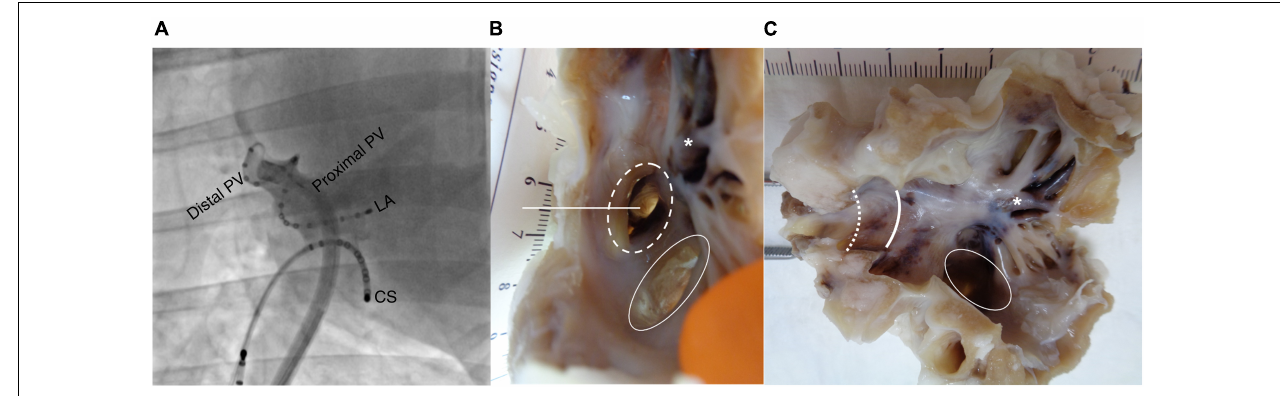
FIGURE 1 | Electrode position and histological preparation. (A) Fluoroscopic image (right anterior oblique view 42 ◦ ) showing the 20-electrode diagnostic spiral catheter positioned in the right pulmonary vein (RPV). A linear catheter is placed in the coronary sinus (CS) as an anatomical reference during the procedure. (B) Image of left atrium (LA) with pulmonary vein (PV) before dissection. Dotted circle: RPV. Intact circle: common left pulmonary vein (LPV). Straight line: incision line through the RPV generating (C) . Asterisk: trabeculated LA tissue. Intact curved line: transition from LA to proximal RPV. Dotted curved line: transition from proximal to distal